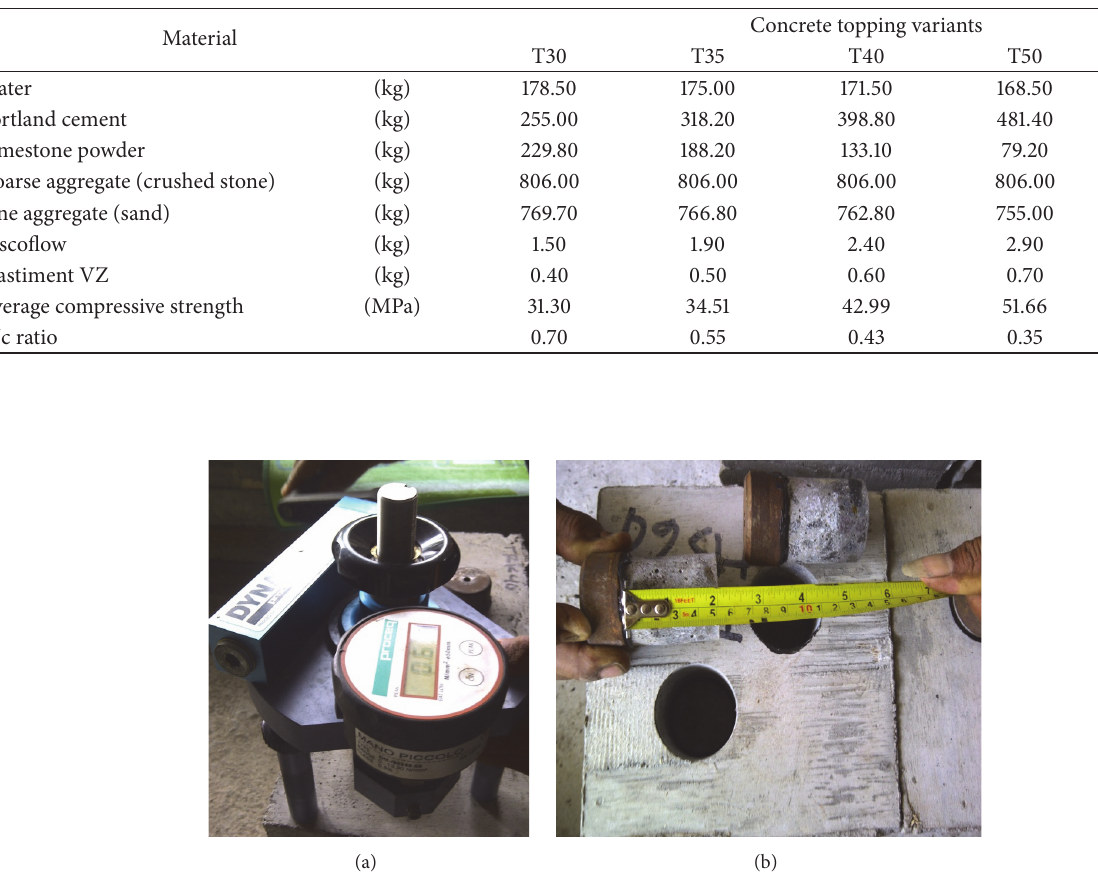
Table 3: Mixtures proportions of SCC as topping layer.